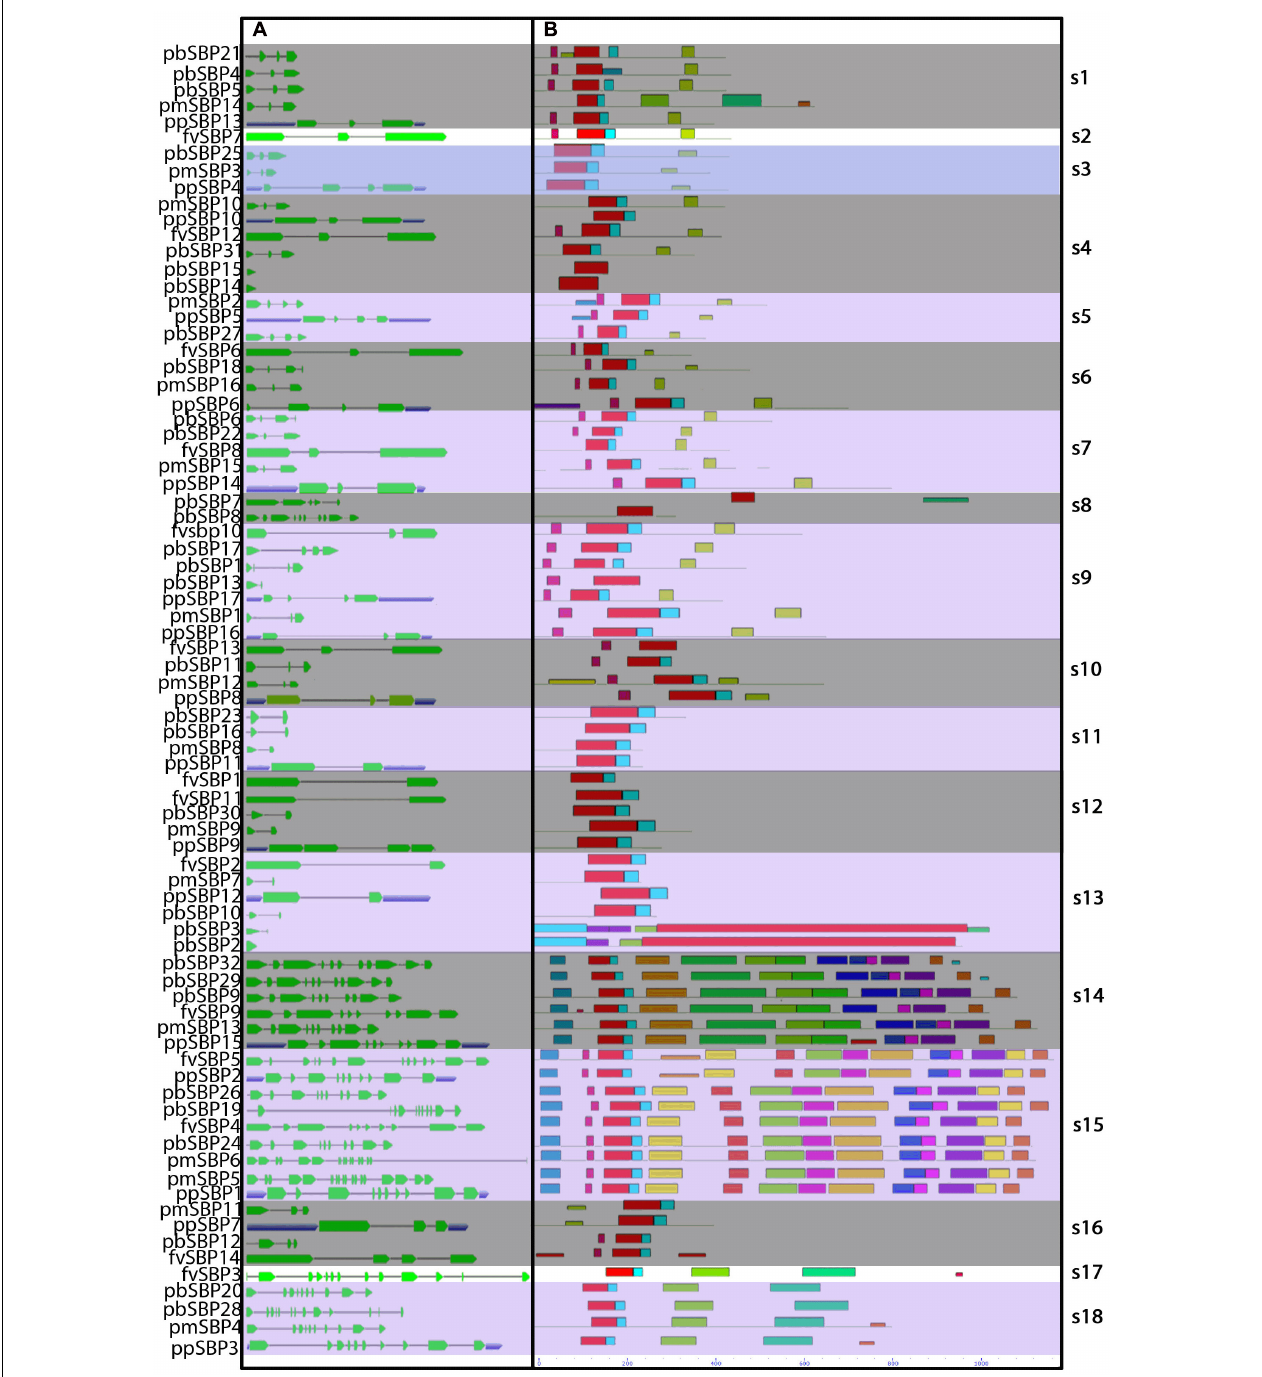
FIGURE 3 | Gene structure and distribution of conserved motif of SBP-box genes in Rosaceae species. (A) Untranslated region (UTRs), introns, and exon indicated by the blue box, thin line, and green box. (B) Conserved motifs located on each gene with relative combined P -value.